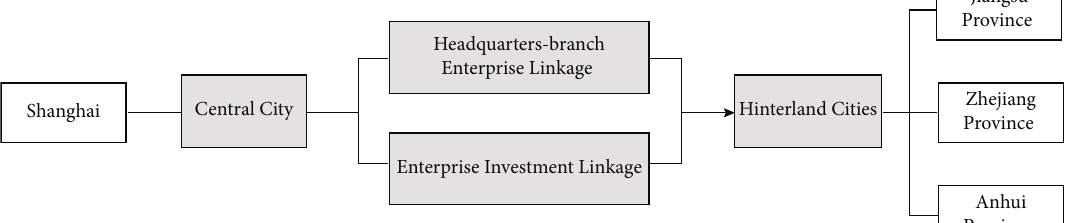
Figure 2: Enterprise linkages between the central city and hinterland